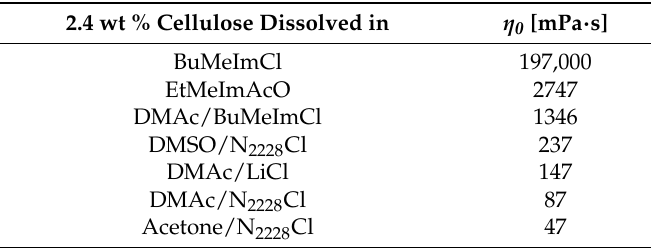
Figure 12. 13 C-NMR spectrum of unmodified cellulose dissolved in dimethyl